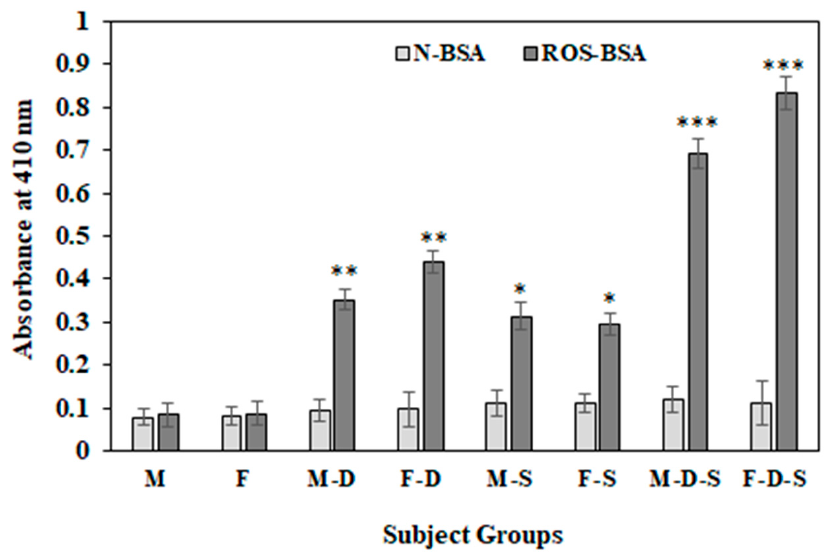
Figure 3. Detection of serum autoantibodies against native and ROS-BSA using direct binding ELISA. ELISA plates were coated with 5 µg/mL antigens. Each group consisted of 15 subjects. Val- ues are given as mean±SD. The t test was adopted for comparison between the two groups, and significance is defined as * p < 0.05, ** p < 0.01, *** p < 0.001. The comparison of autoantibodies against <0.001, respectively. The comparison of autoantibodies against ROS-BSA between group F and